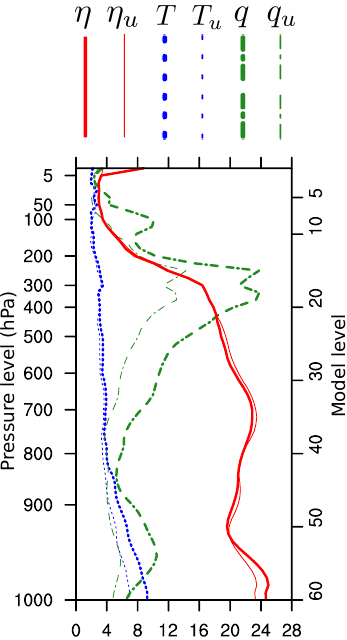
Figure 10. Comparison of K 2 vertical profiles of model variables (thick lines) and control variables (thin lines). Profiles are computed from 3h forecasts valid at 03:00UTC on 4 November